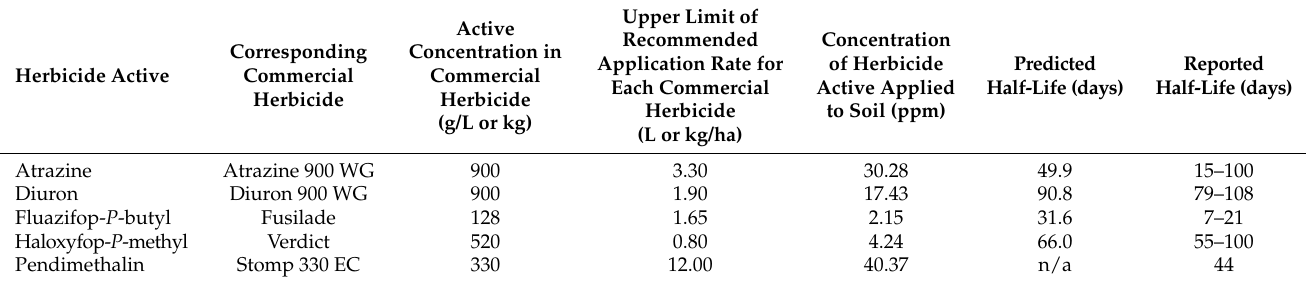
Table 1. Application rates for each herbicide